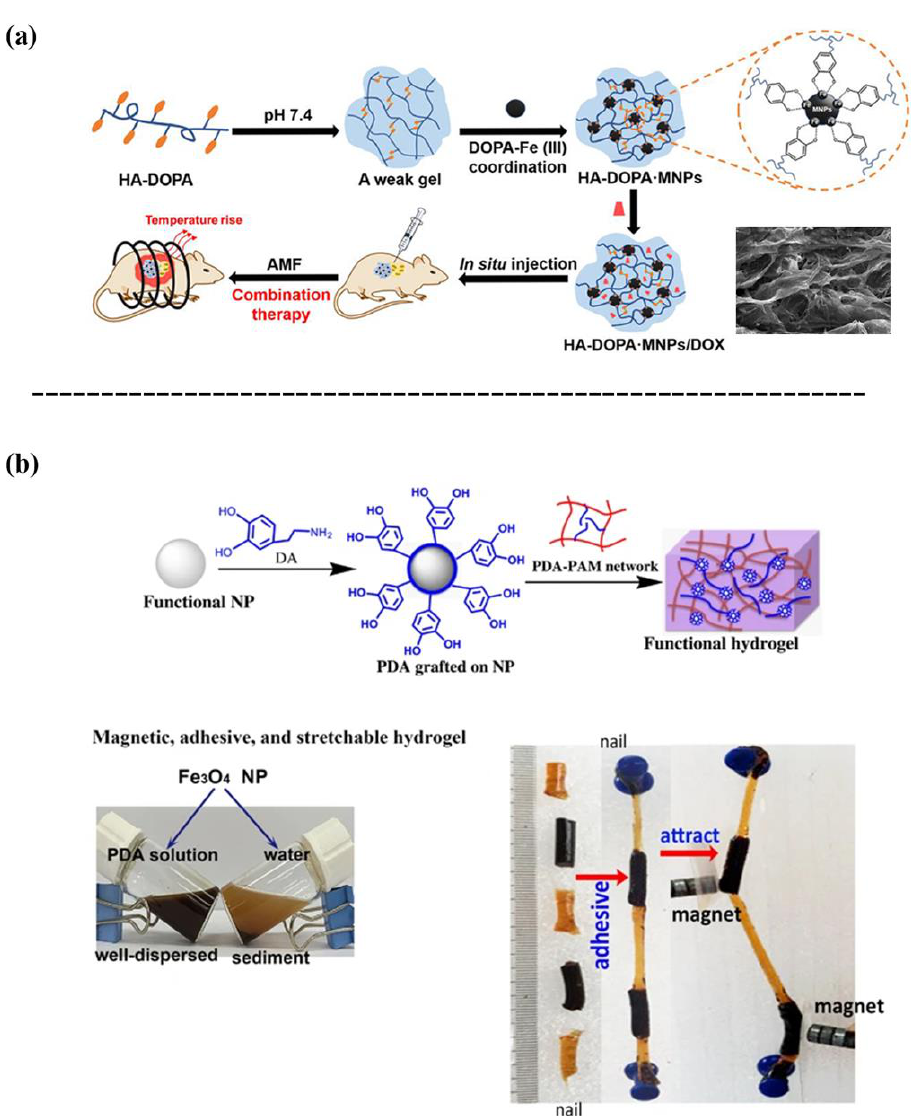
Figure 2. ( a ) Schematic of the preparation of magnetic nanocomposite hydrogels (HA-DOPA MNPs) [51]. ( b ) Magnetic hydrogel formed by incorporating PDA-grafted-Fe 3 O 4 NPs into a PAM hydrogel [52].